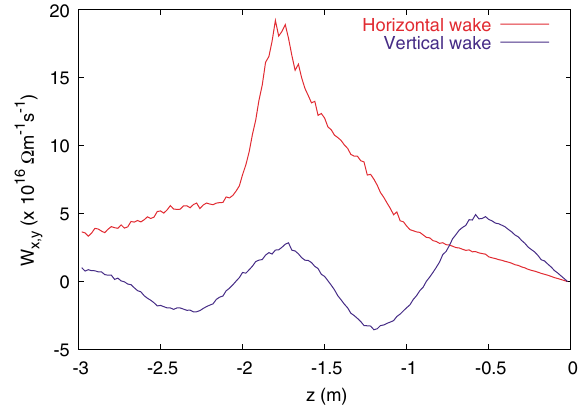
FIG. 10. (Color) Electron cloud horizontal and vertical wake functions for a Gaussian bunch of 2.5 ns rms length (0.75 m) in a combined function magnet (nominal magnetic field gradient of 5 : 2 T = m